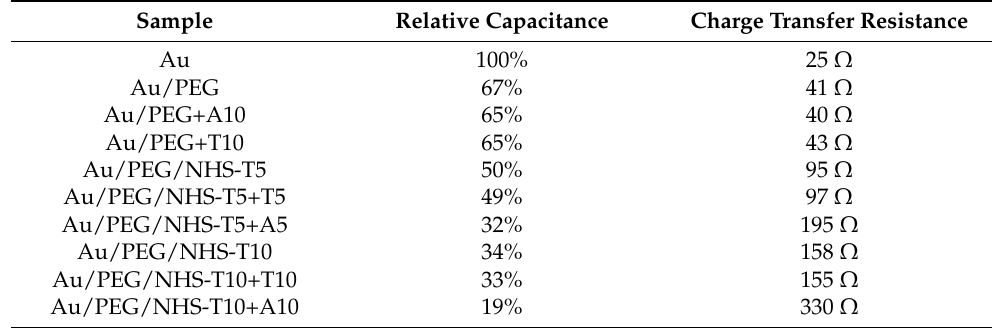
Figure 6. CVs ( a ) and Nyquist plots ( b ) for the blank Au electrode and Au/PEG electrode before and after its exposure to the unmodified ssDNA strands, A10 and T10. Table 1. Capacitance with Respect to the Cell with the Blank Au Working Electrode and the Charge Transfer Resistance Associated with the Specific